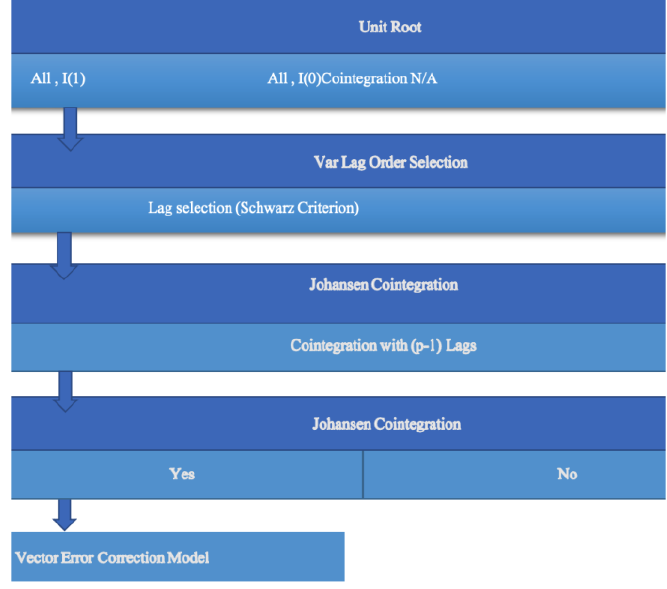
Figure 3: Flowchart for the empirical analysis; Source: Author,